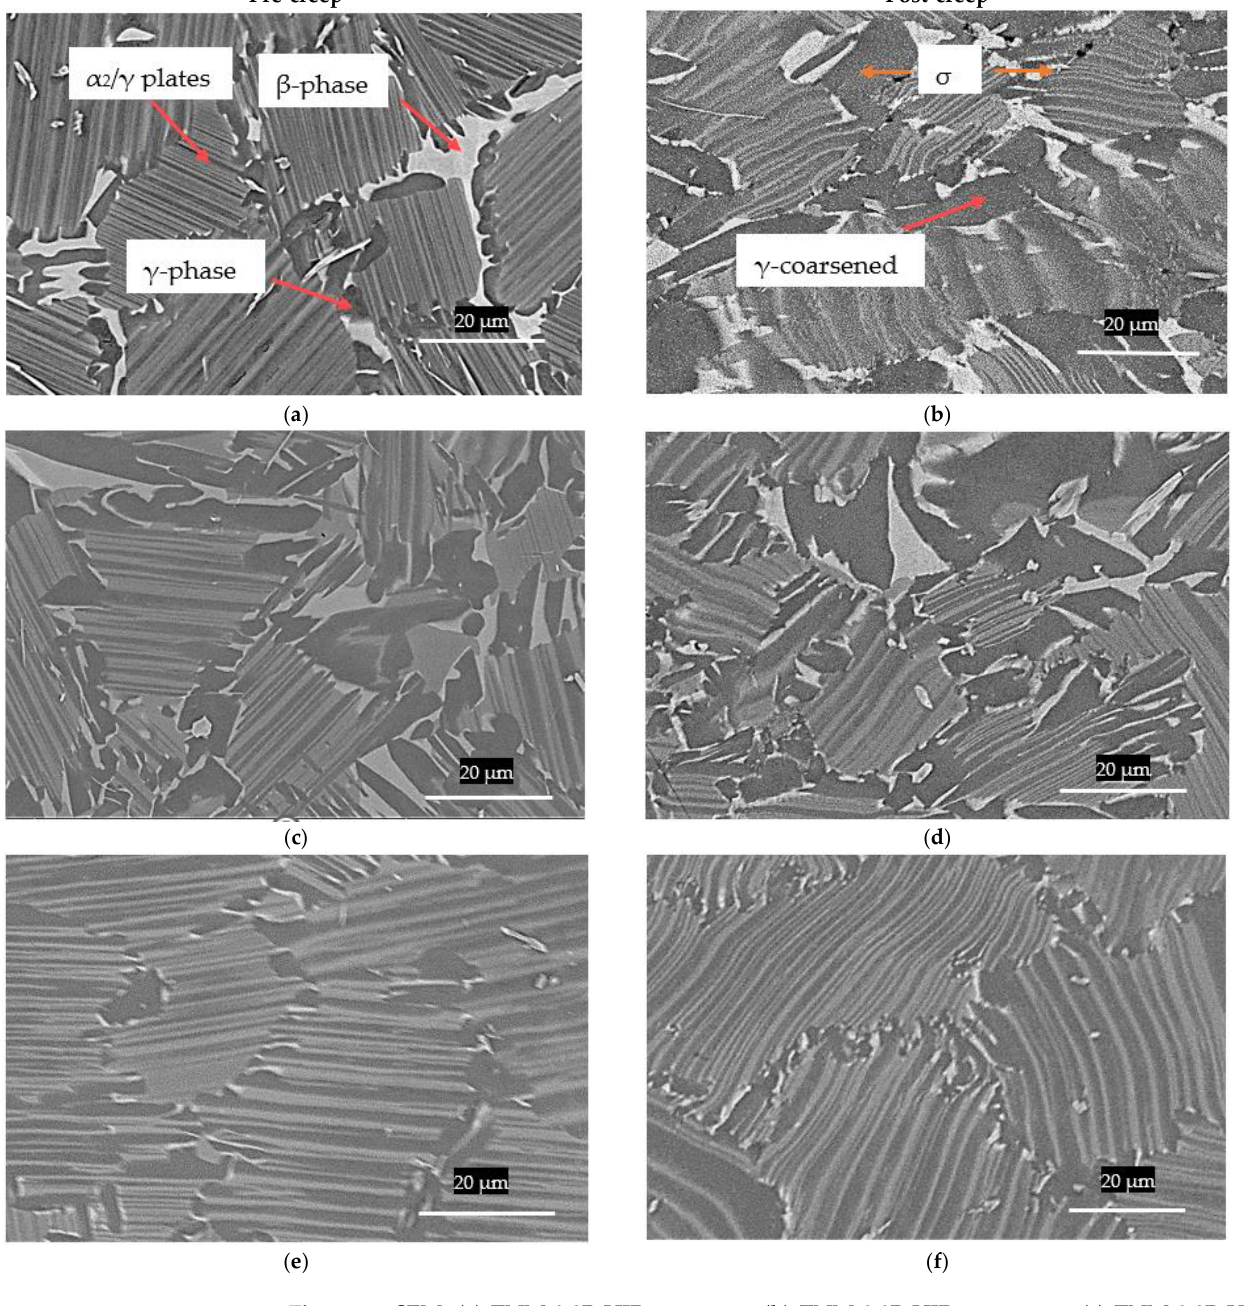
Figure 7. SEM; ( a ) TNM-0.8B-HIP pre-creep, ( b ) TNM-0.8B-HIP post-creep, ( c ) TNM-0.8B-HIP-HT pre-creep, ( d ) TNM-0.8B-HIP-HT post-creep, ( e ) TNM-1.5B-IHT pre-creep, ( f ) TNM-1.5B-IHT post-creep.